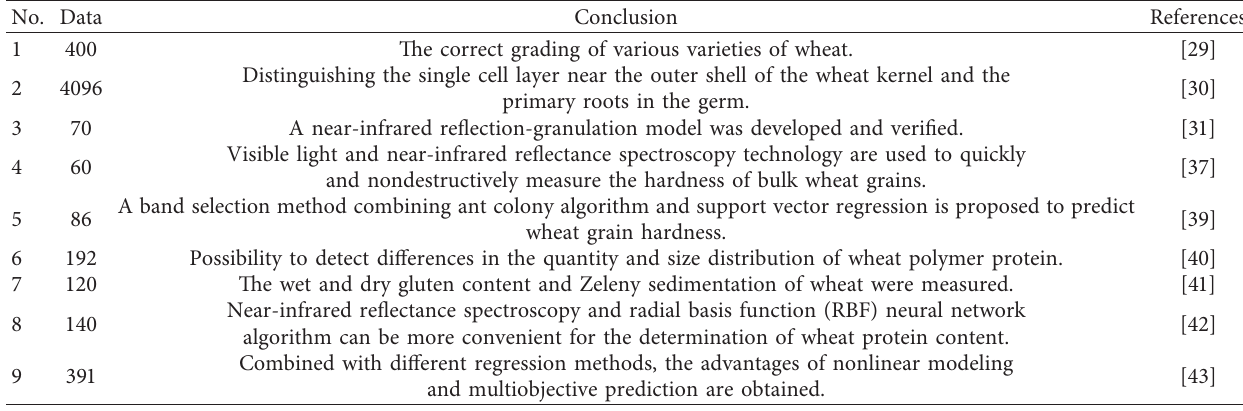
Table 2: Near-infrared spectroscopy test of wheat.